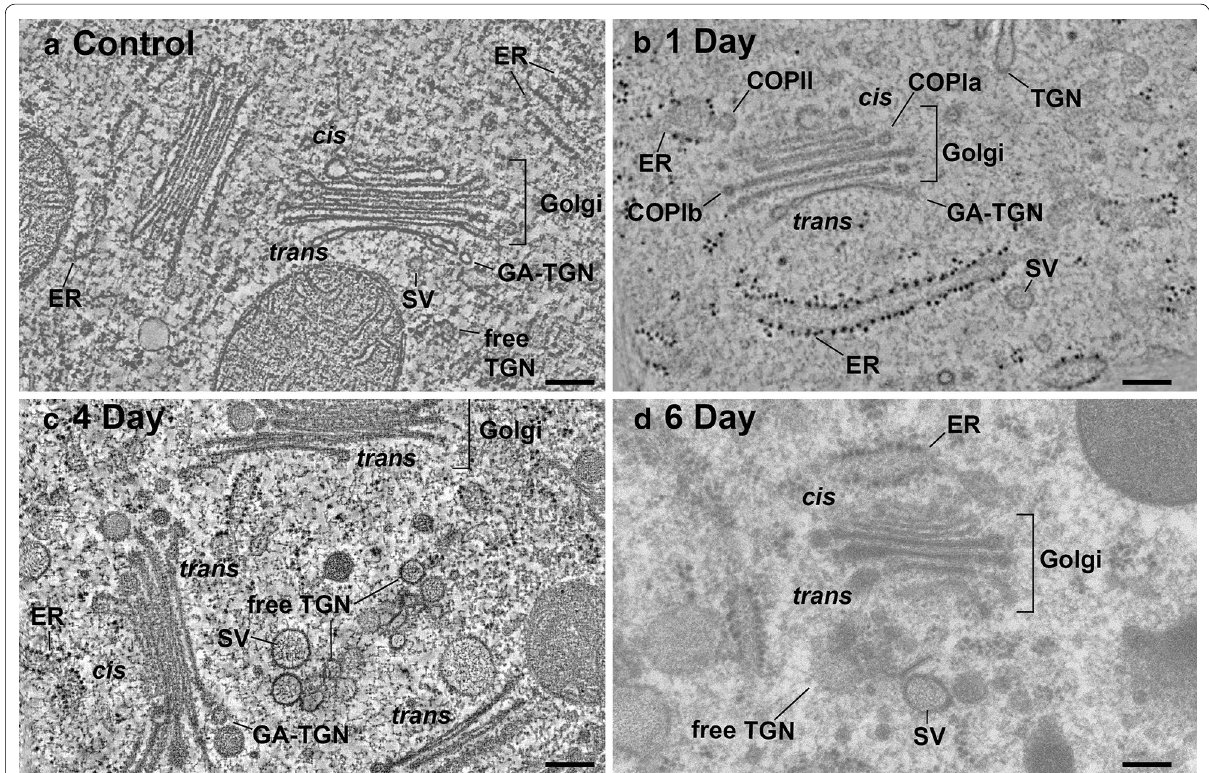
Fig. 4 Electron micrographs of Golgi stacks in high pressure frozen/freeze-substituted Venus flytrap gland cells. Note the increase in size of the inflated cisternal margins of the Golgi-associated trans Golgi network (GA-TGN) and the free TGN elements and of the size of the secretory vesicles (SV) in the 4 and 6 day samples compared to the control and 1 day samples. Peeling GA-TGN cisternae are seen in a – c , and free TGN cisternae in a , c and d . In b , a COPII bud is seen at an ER export site adjacent to the cis -side of the Golgi stack, and COPIa- and COPIb-type vesicles are associated with cis and medial Golgi cisternae. Bars 0.2